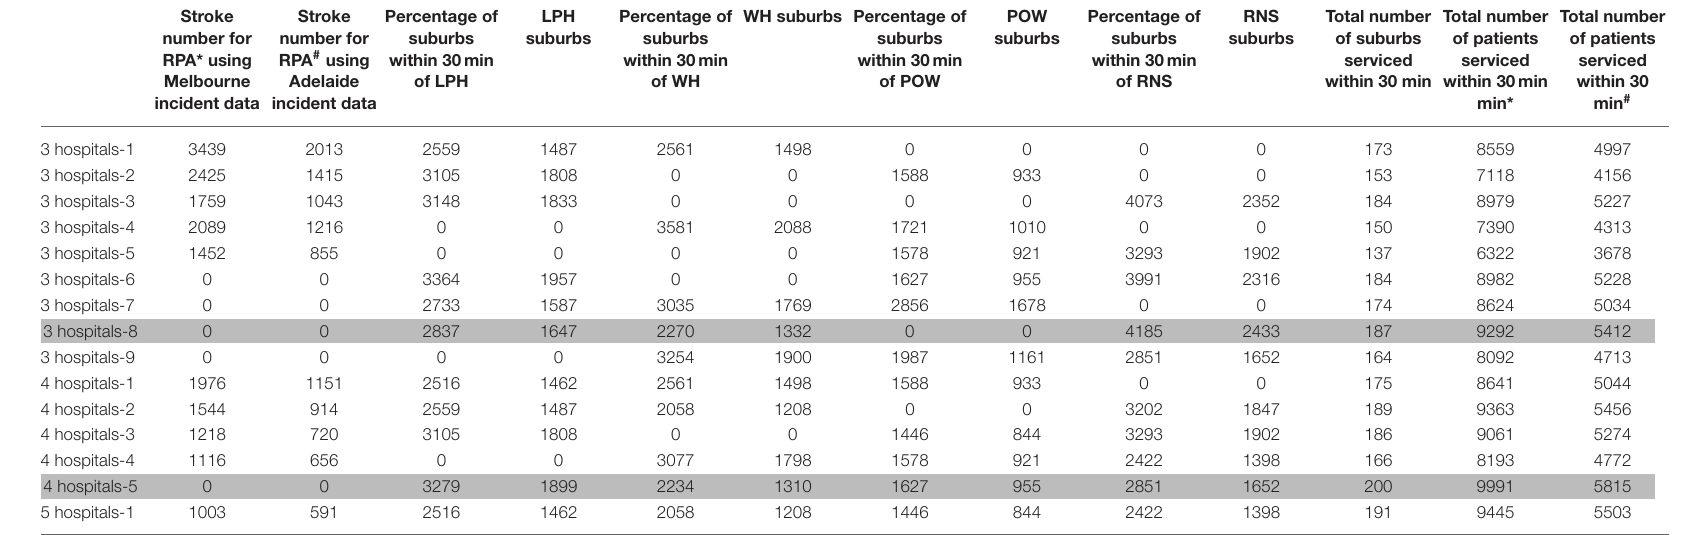
* Melbourne stroke incident study; # Adelaide stroke incident study. The shaded rows represent the combinations with the best